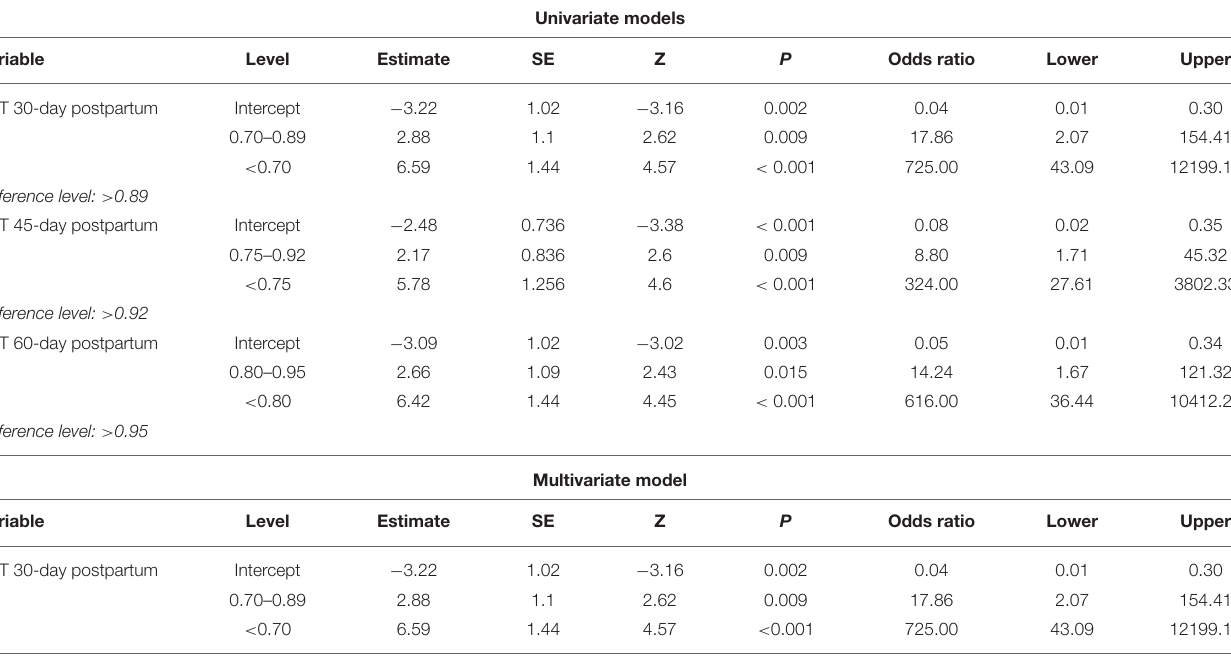
TABLE 2 | Association of the backfat thickness (BFT) and the cyclicity restarting at 60-day postpartum; univariate and multivariate results are presented. Univariate